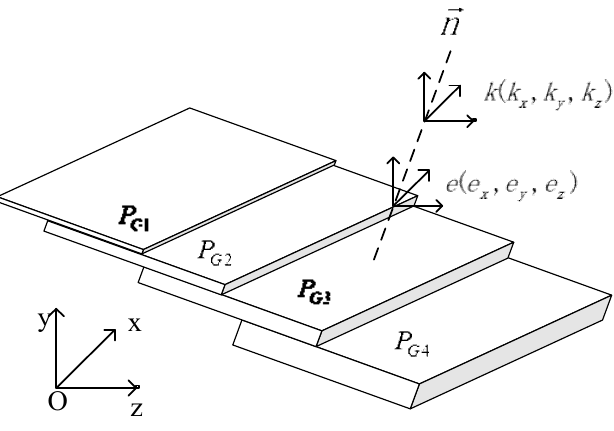
Figure 7. Schematic of the automatic calibration method.